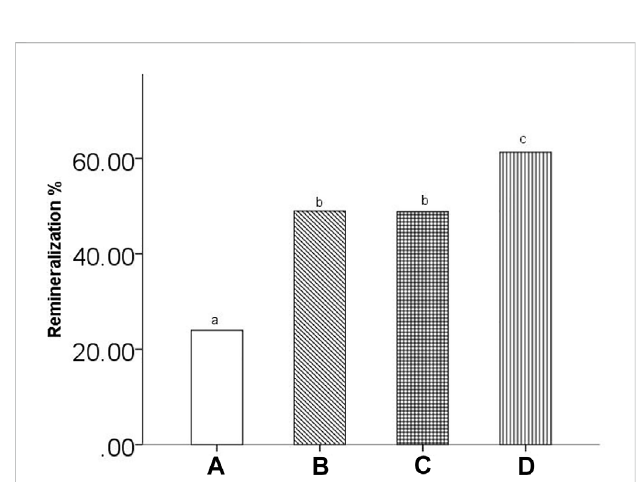
FIGURE 5 The remineralization rate of all groups. (A) remineralizing medium group; (B) studied peptide 1 group; (C) studied peptide 2 group; (D) fl uoridate group. The same letter above the bar chart shows that no difference is statistically signi fi cant ( p >